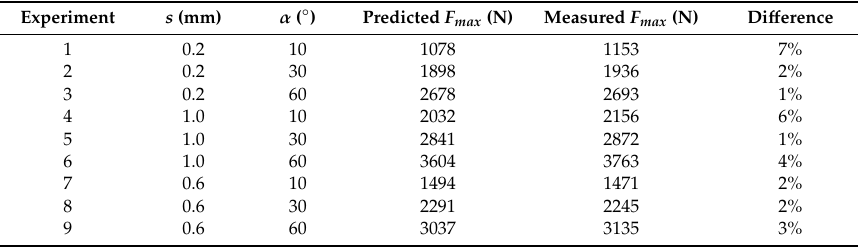
Table 9. Comparison of statistically predicted magnitudes of the total machining force F max according to the predictive Equation (2) and measured the total machining F max.